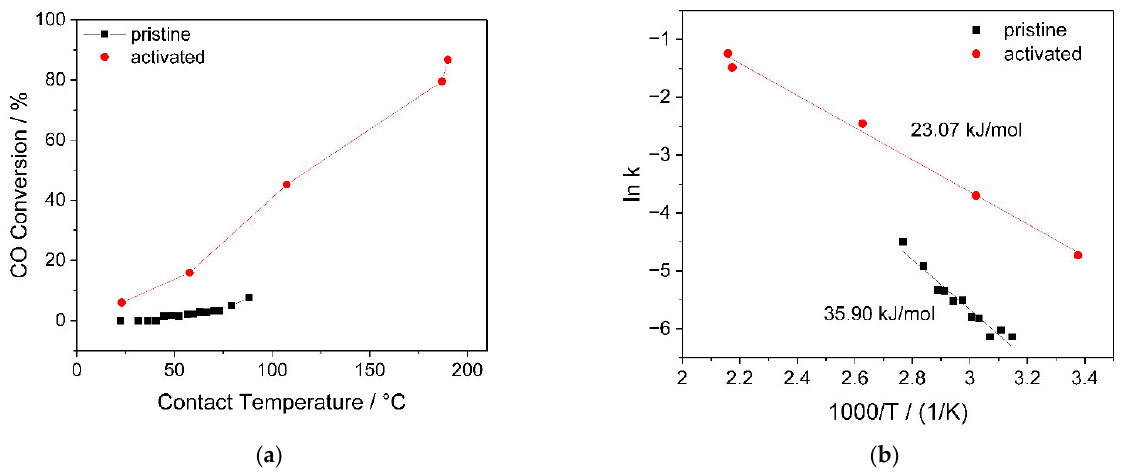
Figure 5. ( a ) CO oxidation over an LSC-82 catalyst under MW-heating before (pristine) and after (activated) a sustained activation treatment under thermal instability conditions. ( b ) The same data represented as Arrhenius plot.